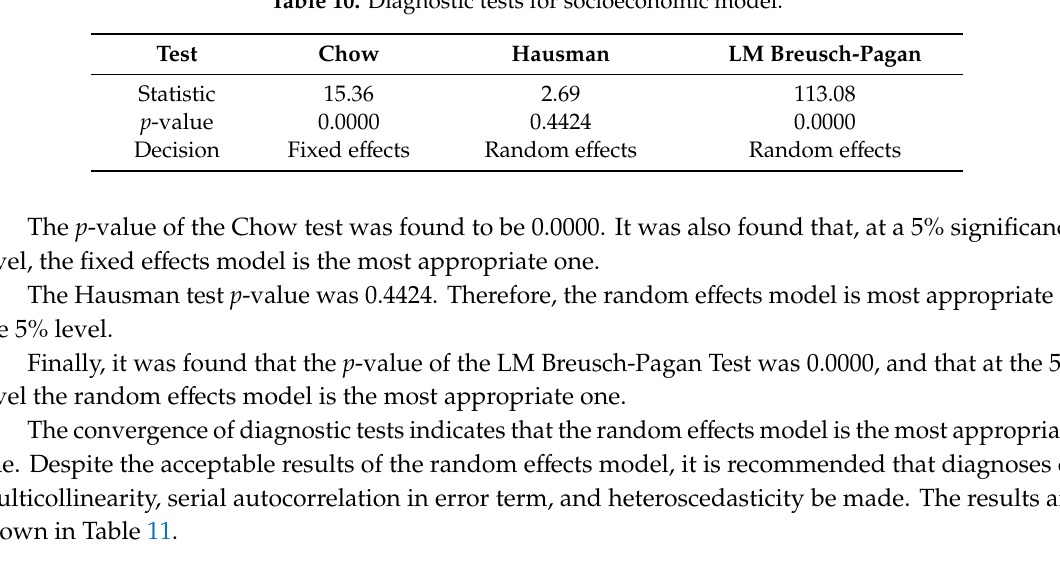
Table 10. Diagnostic tests for socioeconomic